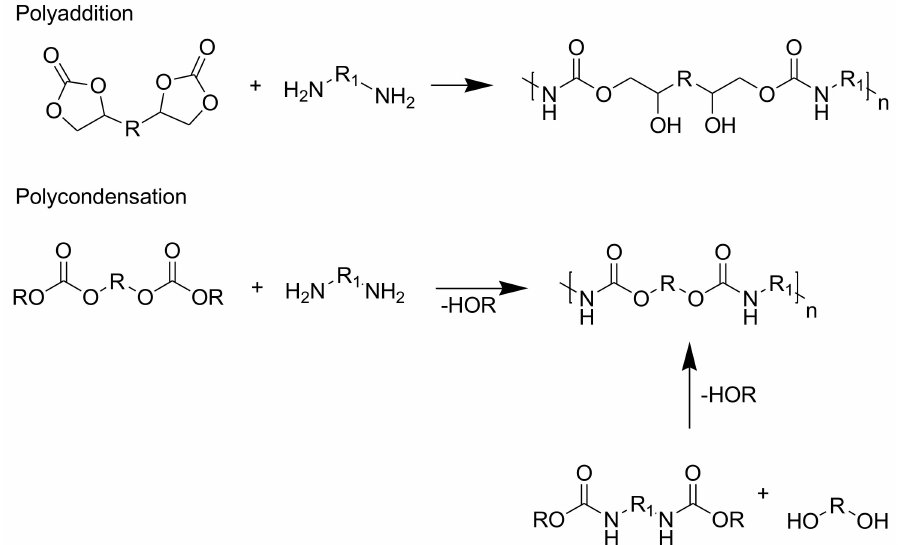
Figure 4. Comparison of NIPU structure produced by polyaddition of bifunctional cyclic carbonate and diamine as well as polycondensation [80,149].